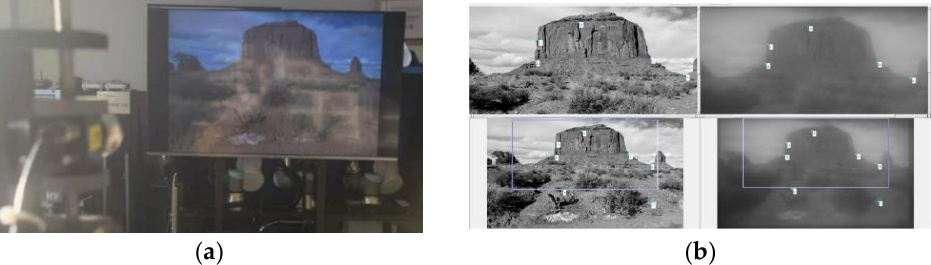
Figure 8. The key procedure constructing manual registering database; ( a ) The display-capture lab setup; ( b ) The interactive selection of artificial feature points in MATLAB software.